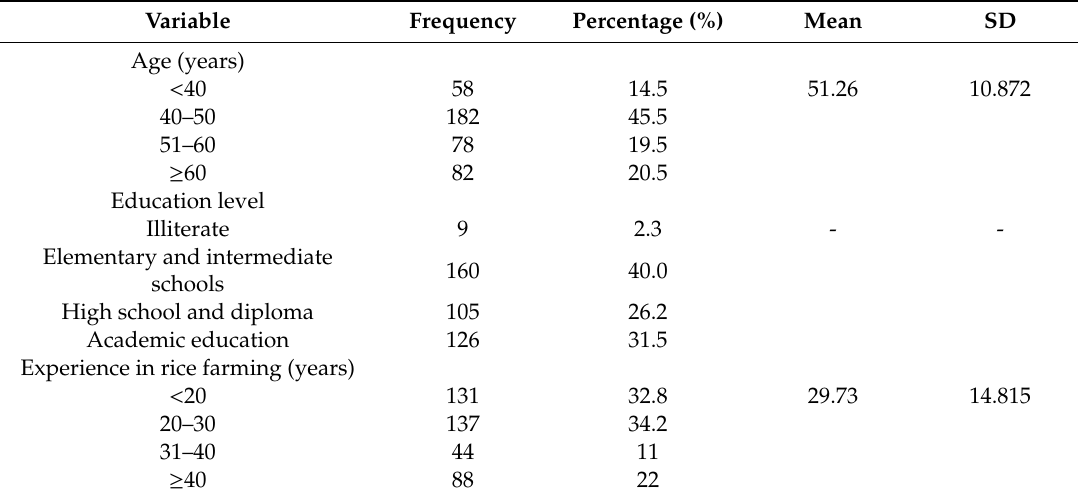
Table 1. Demographic features of rice growers in Rudsar County ( n =